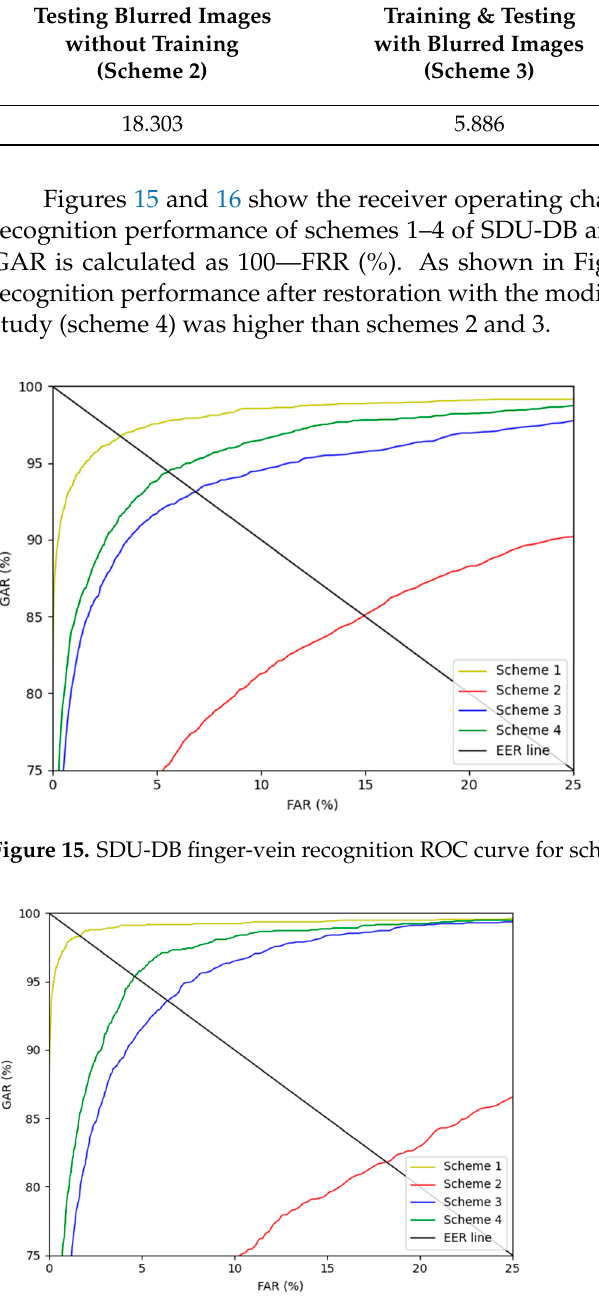
Figure 16. PolyU-DB finger-vein recognition ROC curve for schemes 1–4.